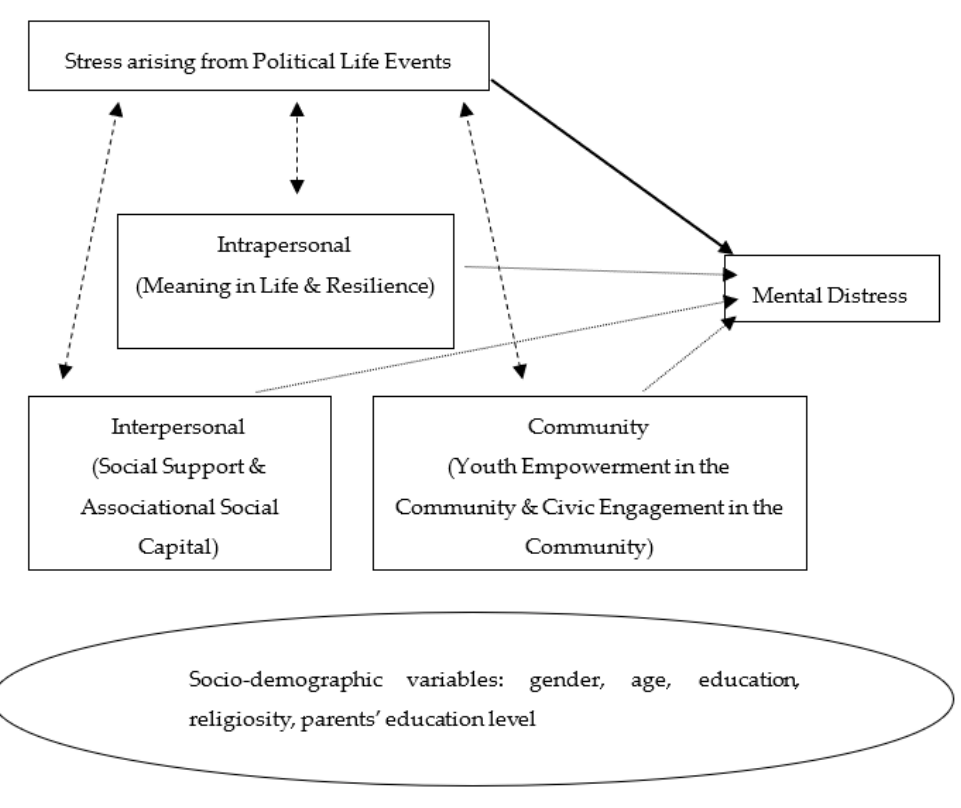
Figure 1. Conceptual